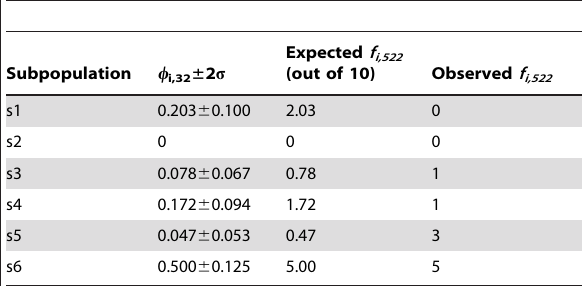
Table 2. Subpopulation frequencies: inferred, expected, and